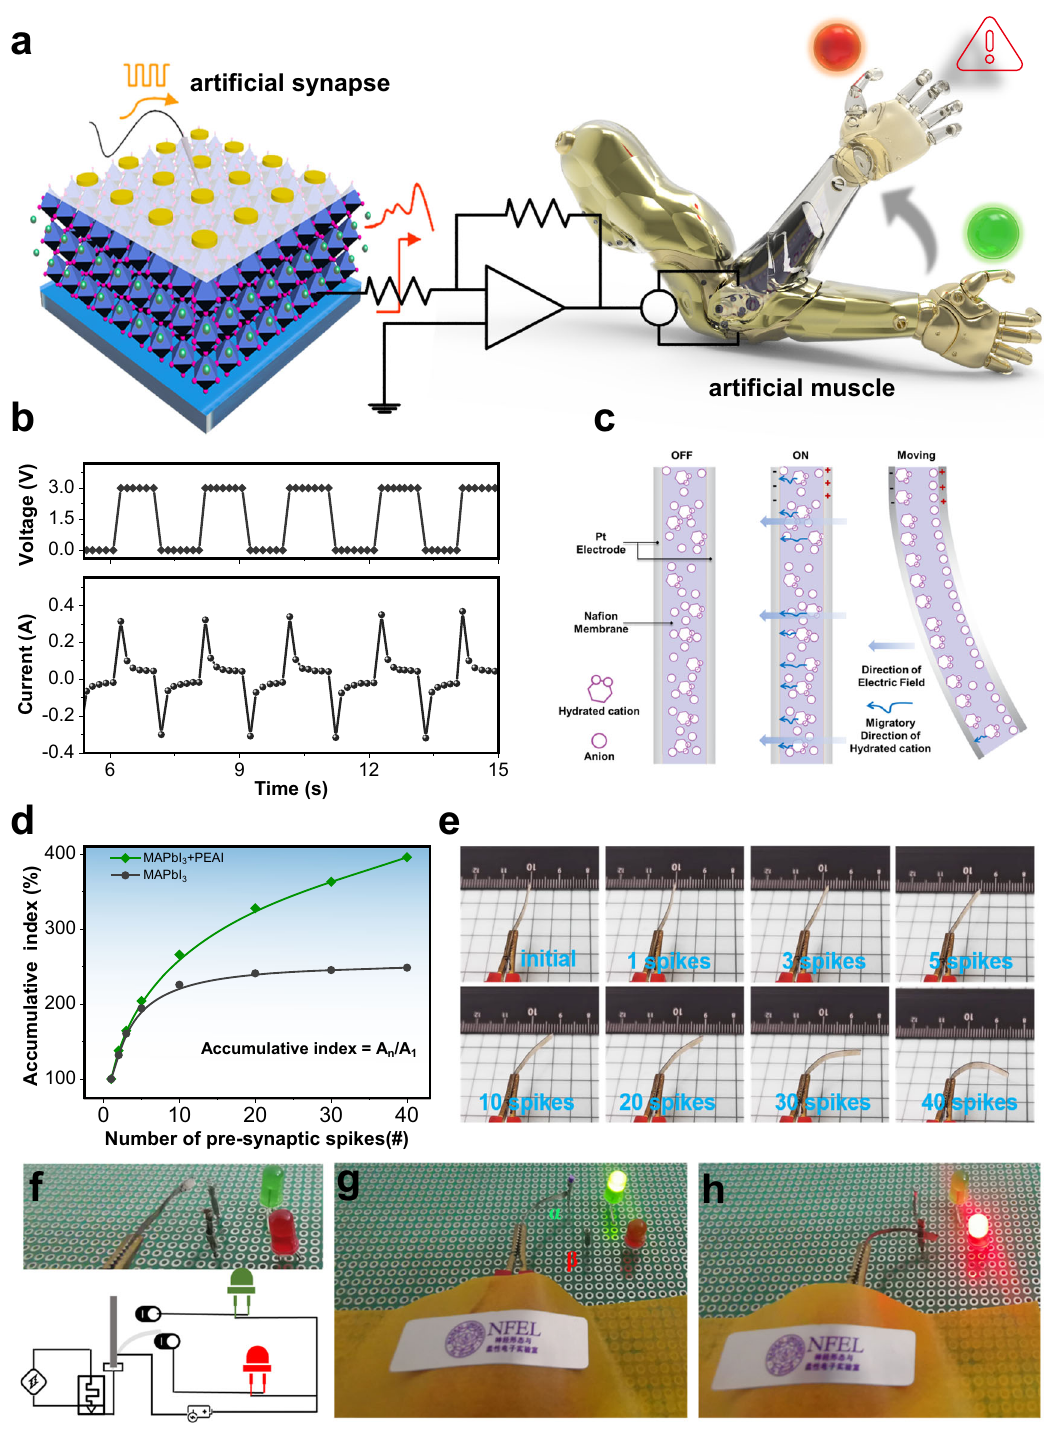
Fig. 5 | Neuromuscular electronic system. a Con fi guration of perovskite arti fi cial synapse and neuromuscular electronic system. b Current response in IPMC at an operating voltage of 3V. c Structure and motion mechanism of IPMC arti fi cial muscle. d Accumulative index as triggered by consecutive presynaptic spikes on